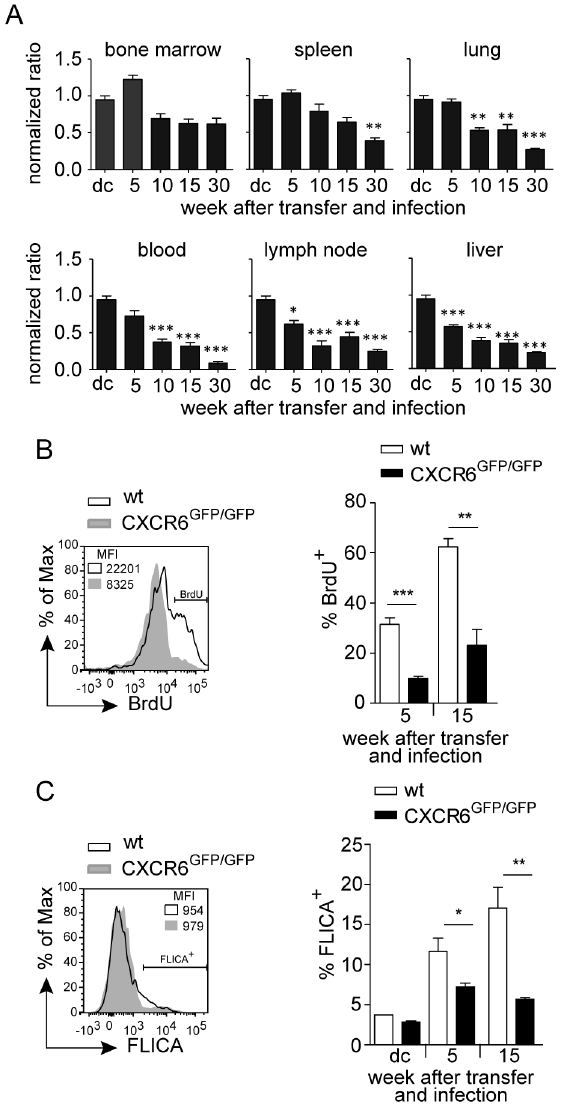
Figure 5. CXCR6 controls tissue distribution and survival of pre-activated CD8 + T cells. Purified CD8 + T cells from wt OT–I and